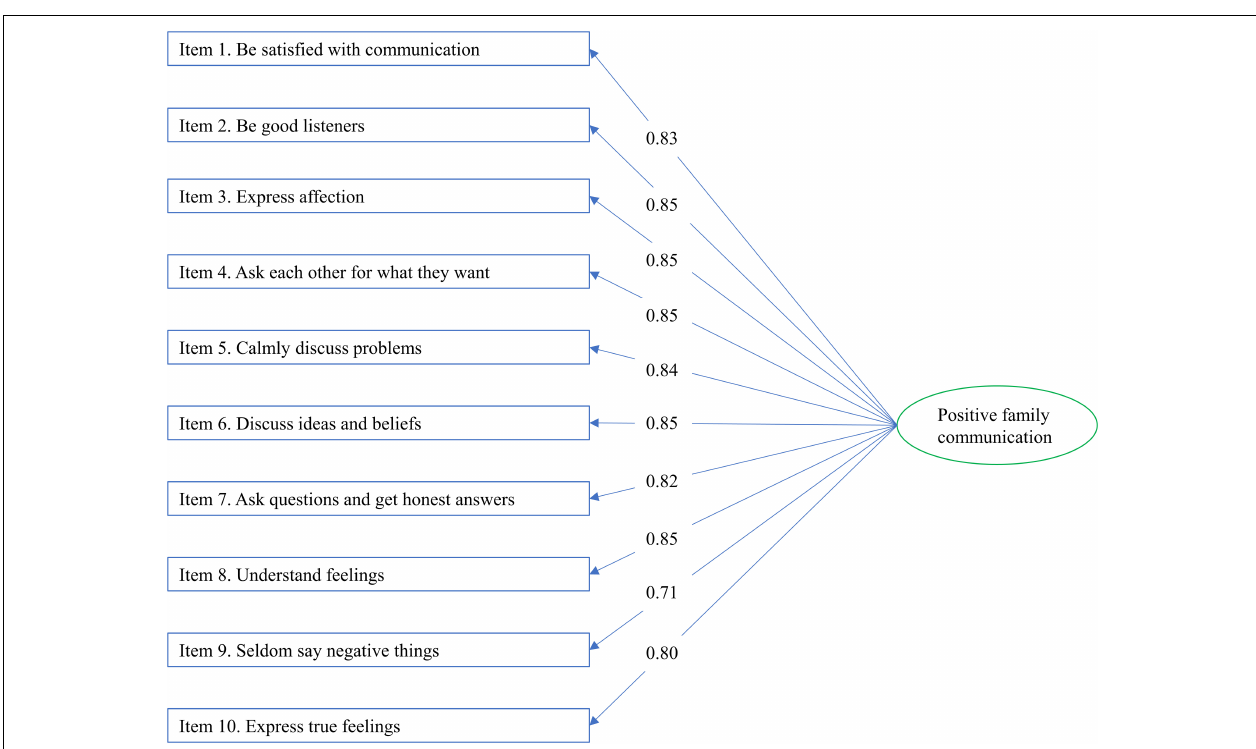
FIGURE 2 | The final one-factor model of the Family Communication Scale indicated by the confirmatory factor analysis with standardized path coefficients in the community-based sample ( N = 1983).